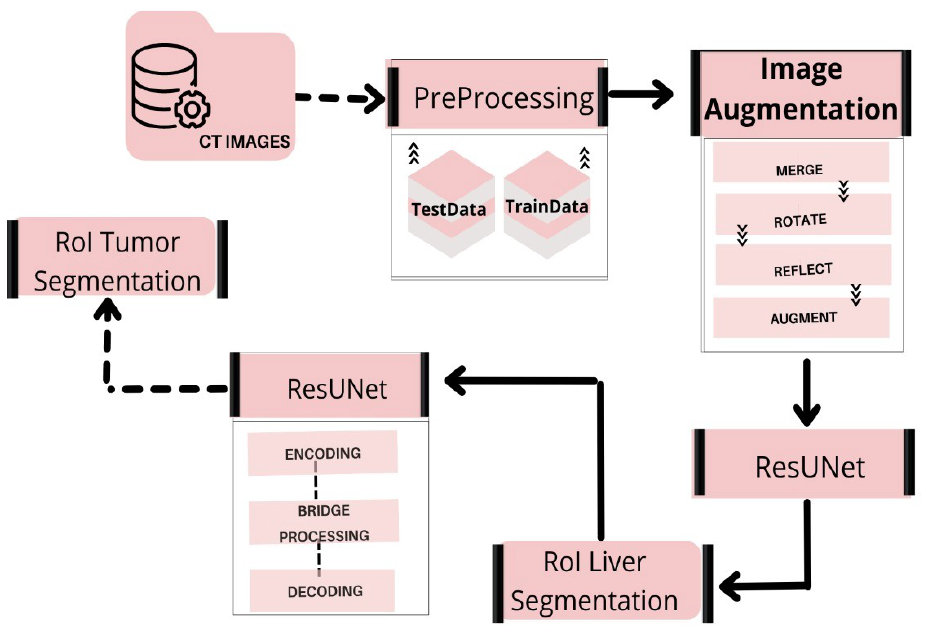
Figure 1. Overview of our proposed